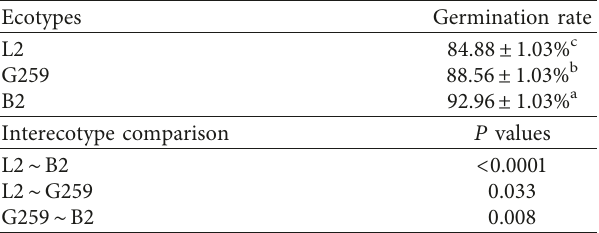
Table 3: Effect of ecotypes on germination